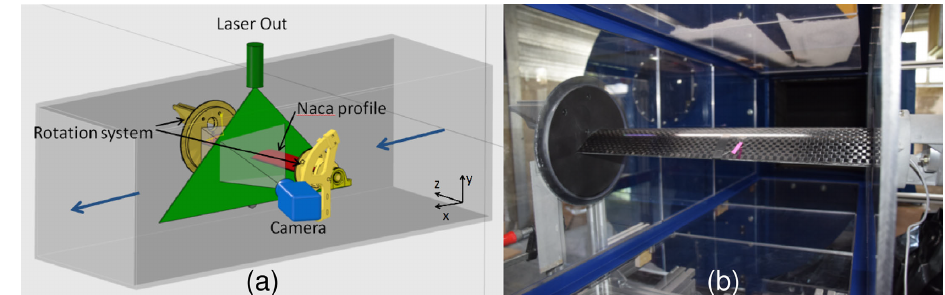
Figure 3. Experimental setup in the LHEEA wind tunnel: (a) scheme of the PIV setup with the framework of the axis ( x , y , z ). (b) The 2D blade section mounted in the test section with the e-TellTale sensor in pink.